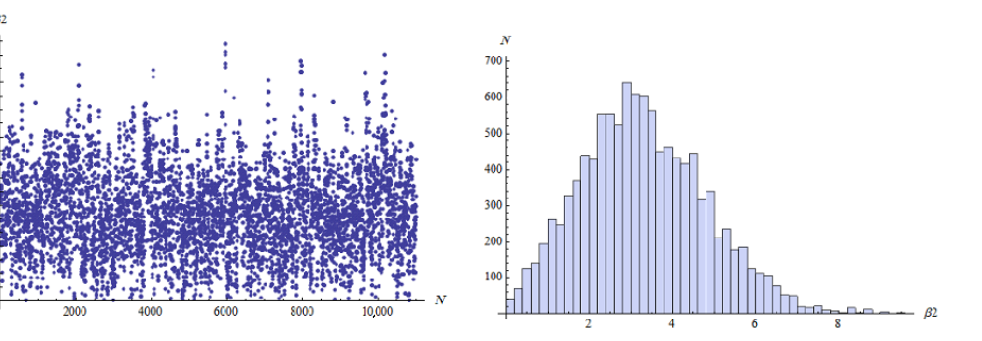
Figure 7. Trace ( Left ) and histogram ( Right ) plots of the parameter β 2